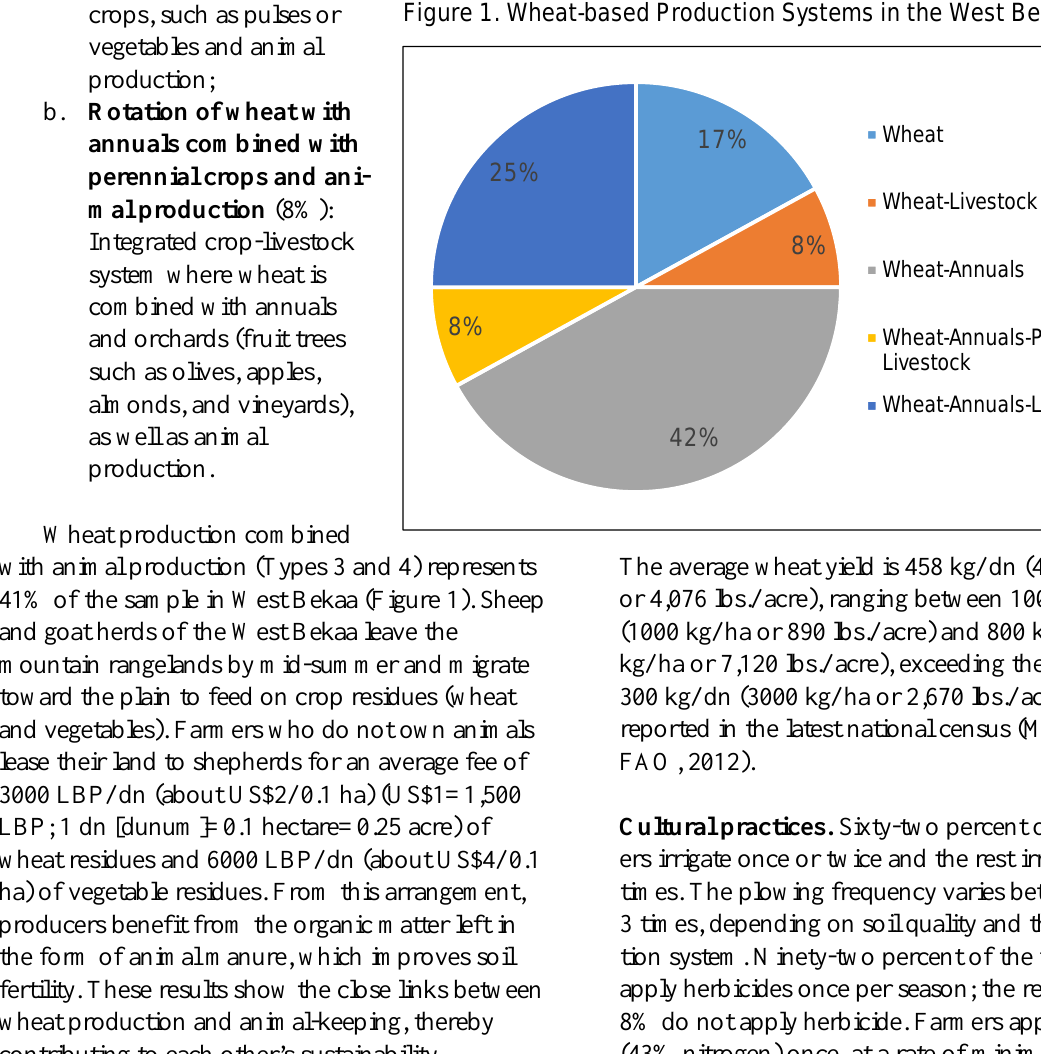
Table 1. Wheat Producers vs. Land Tenure and Land Dedicated to Wheat Production